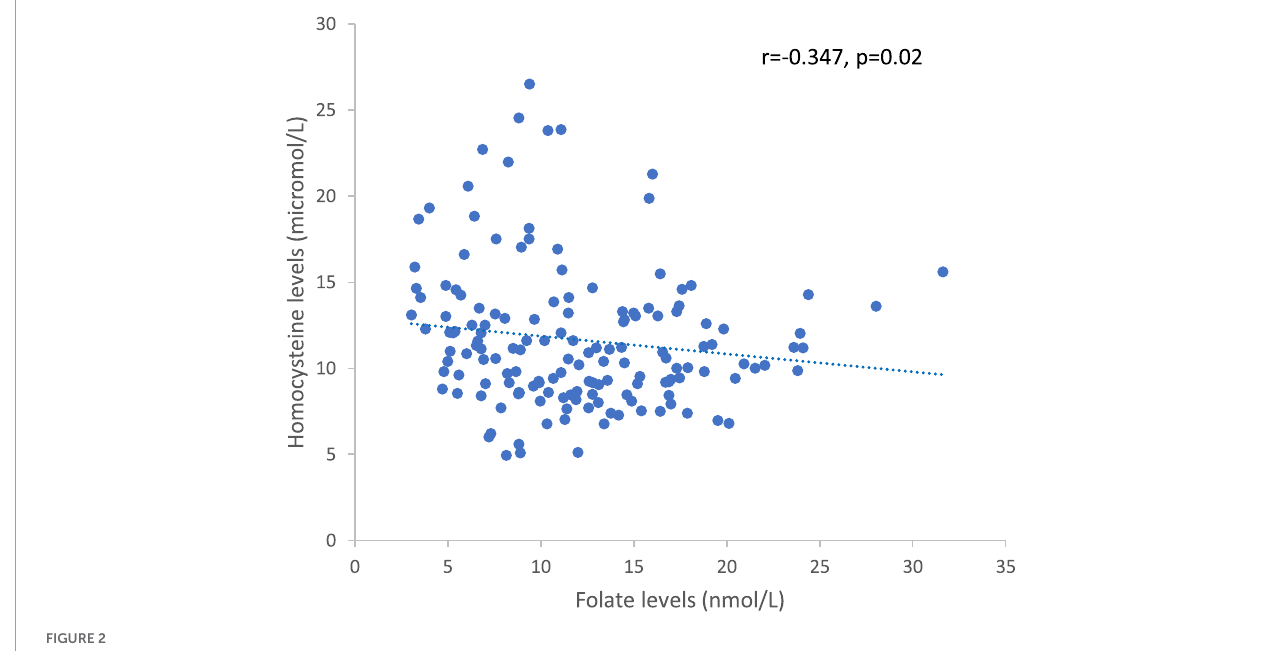
FIGURE2 Correlation between homocysteine and folate levels in the whole sample.